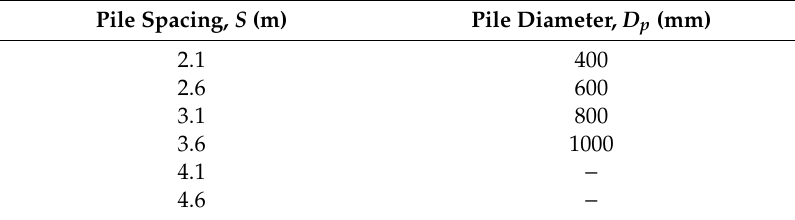
Table 8. Variation range of the parameter values for the parametric